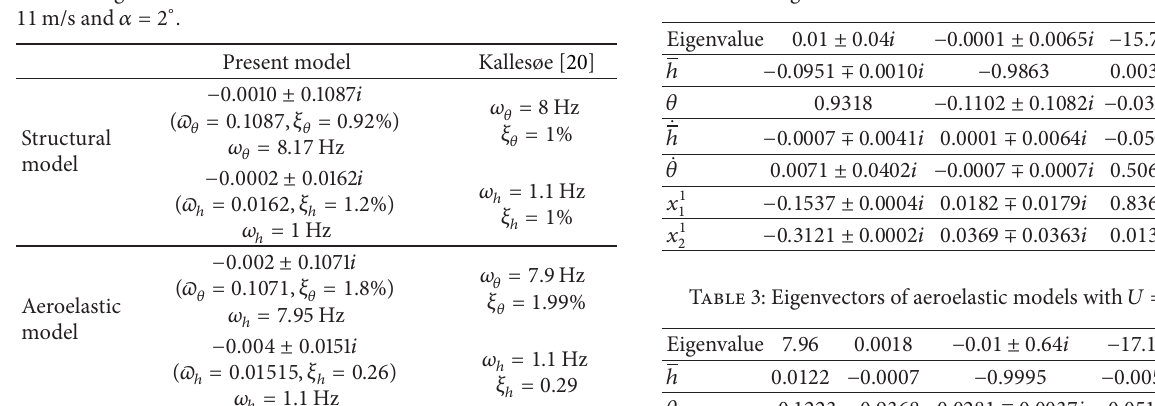
Table 2: Eigenvectors of aeroelastic models with 𝑈 = 16 m/s.